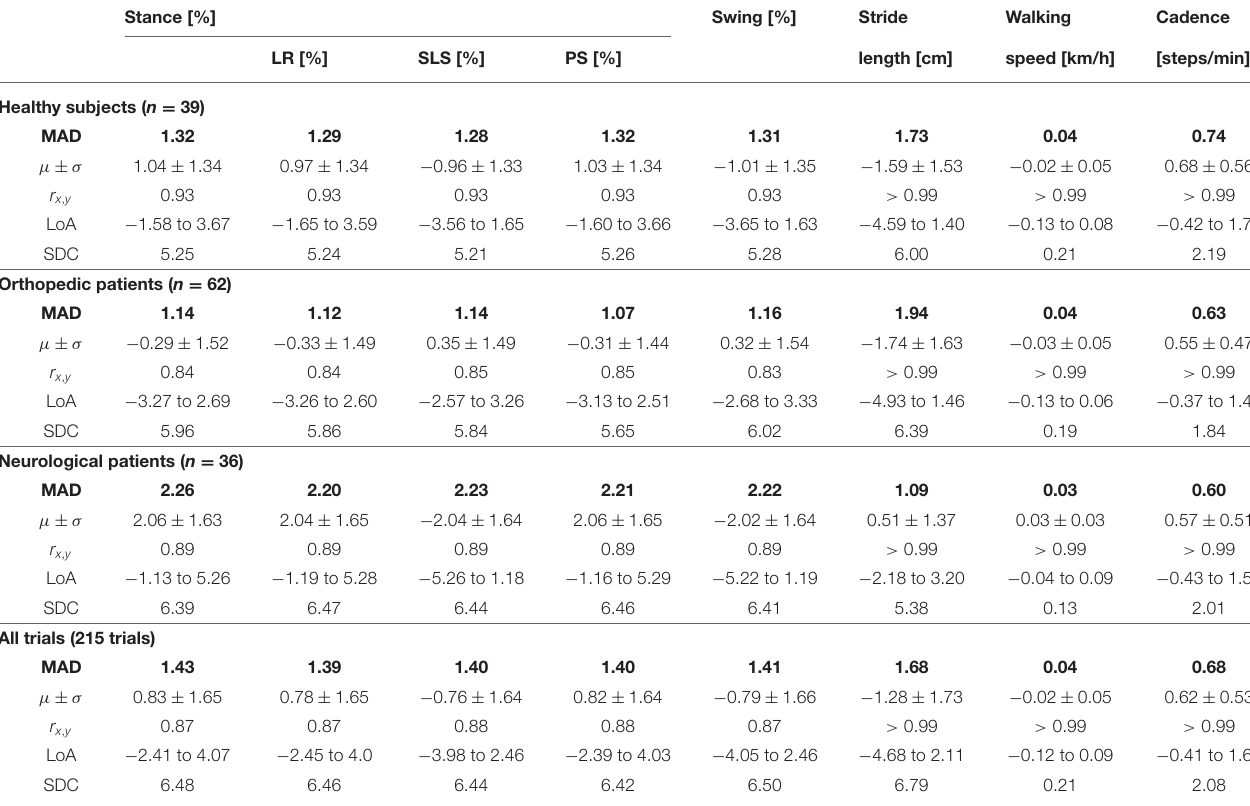
TABLE 3 | Deviation between IMU-based and Zebris gait parameters. Stance [%] Swing [%] Stride Walking Cadence LR [%] SLS [%] PS [%] length [cm] speed [km/h]